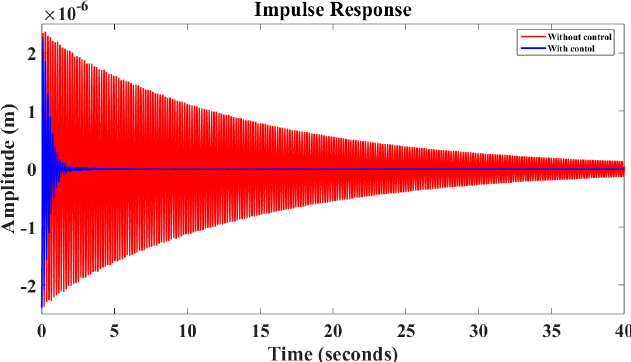
Figure 4. Impulse response of the beam (Sensors in FE1, Q = 10 13 , R = 1, Gc = 100).